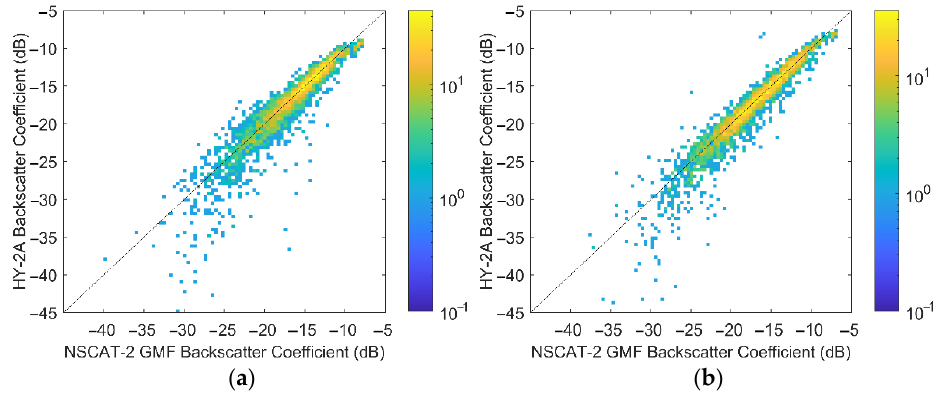
Figure 6. Scatter plots of NSCAT ‐ 2 GMF σ 0 and HY ‐ 2A σ 0 paired data. ( a ) HH polarization. ( b ) VV polarization. The dashed line in this figure is the diagonal line.